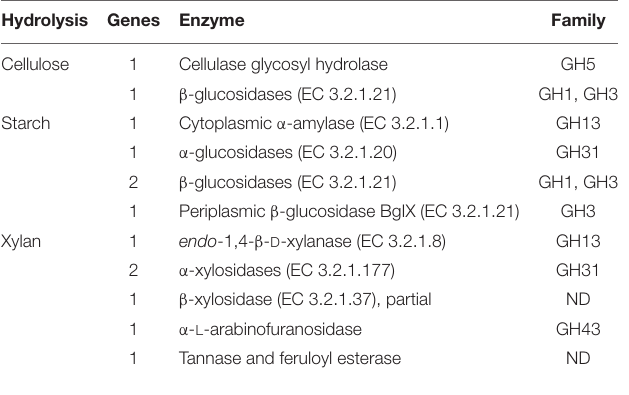
TABLE 2 | Identification of xylan, cellulose, and starch hydrolytic enzymes in the genome of Rahnella sp. ChDrAdgB13. Hydrolysis Genes Enzyme Family